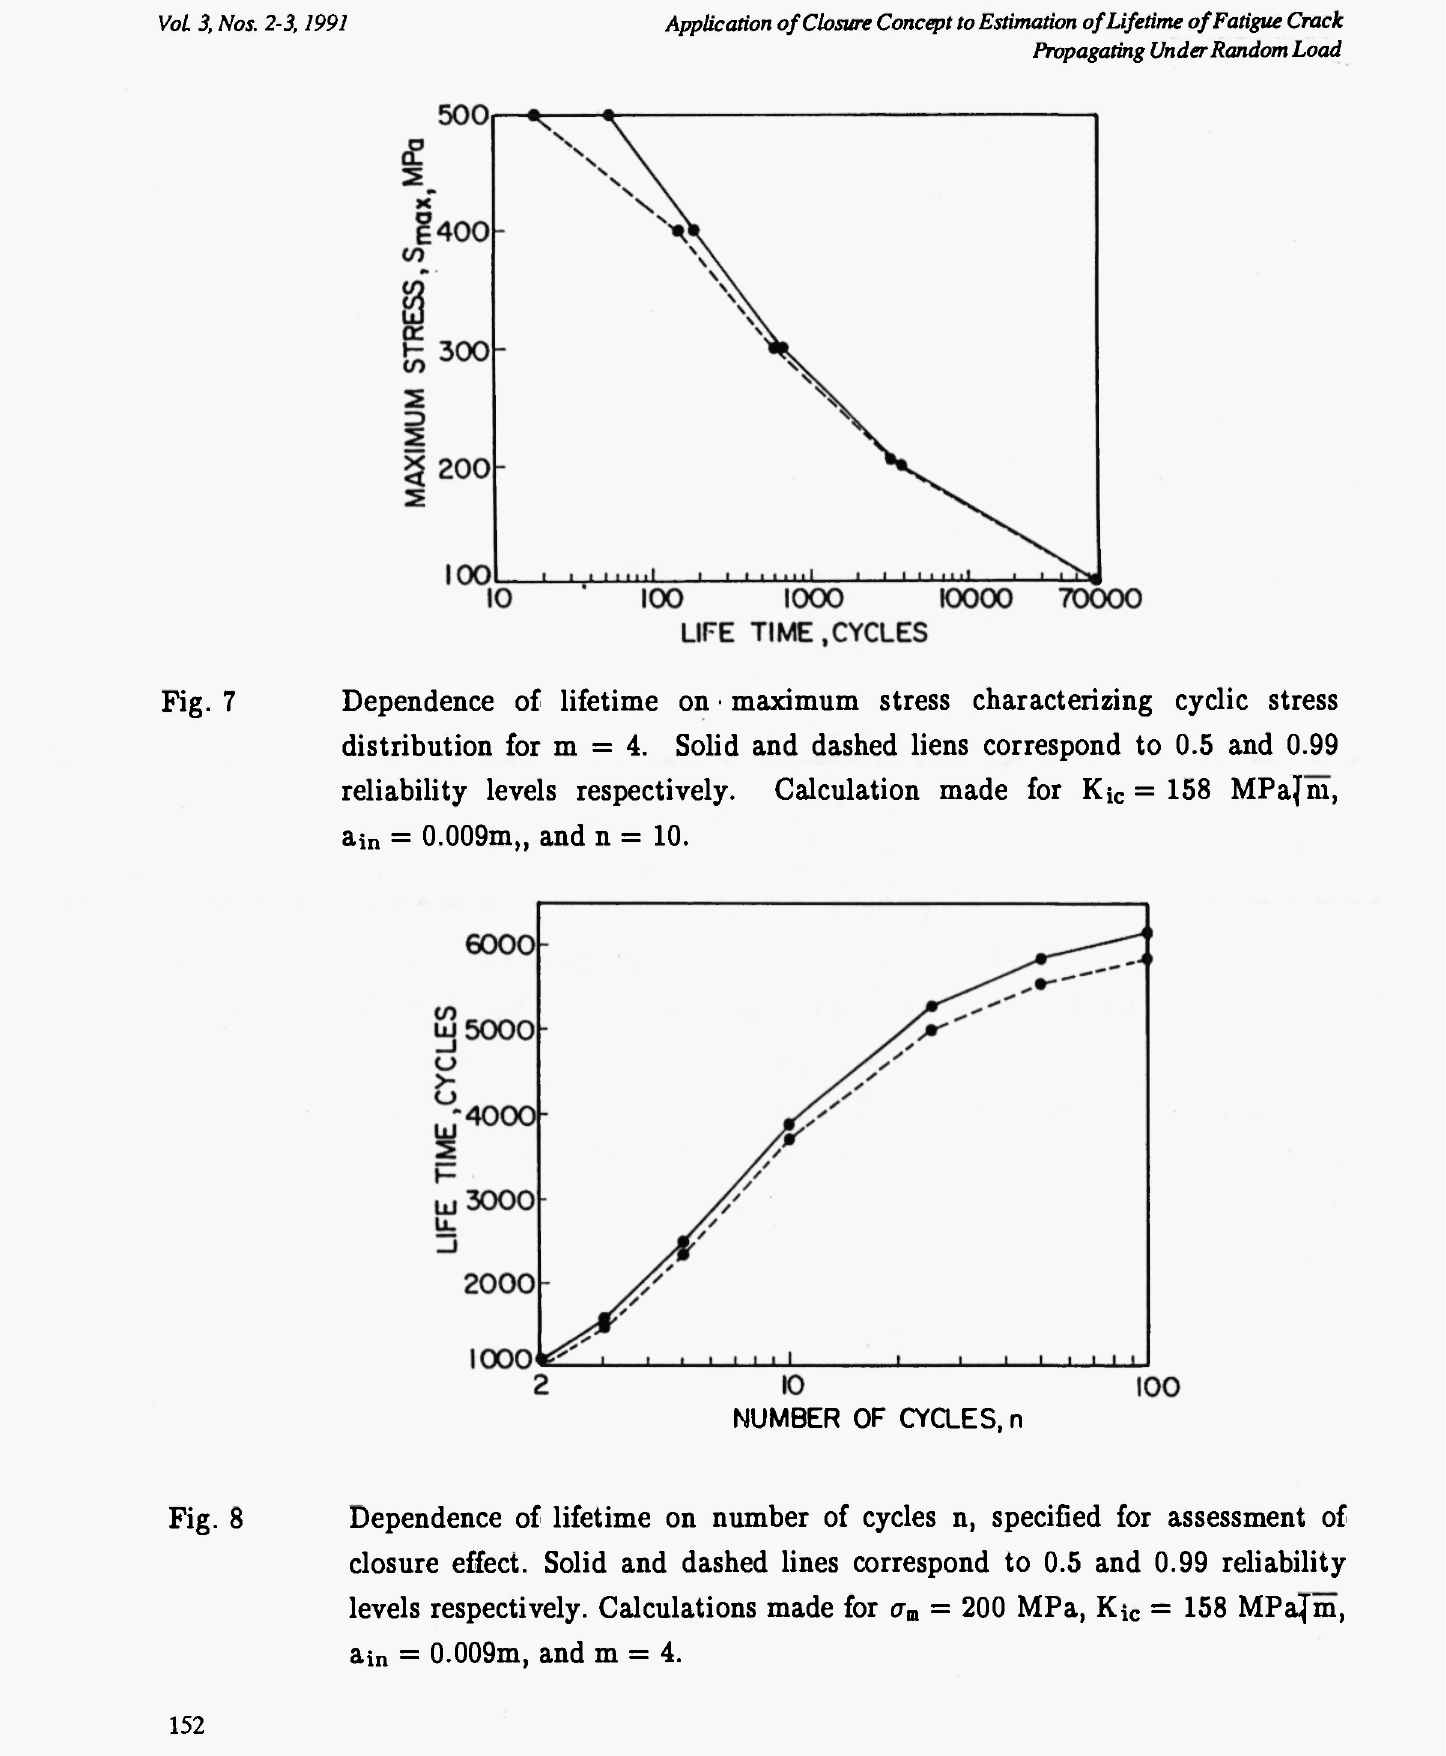
= 200 MPa, Ki = 158 MPa^m, m C